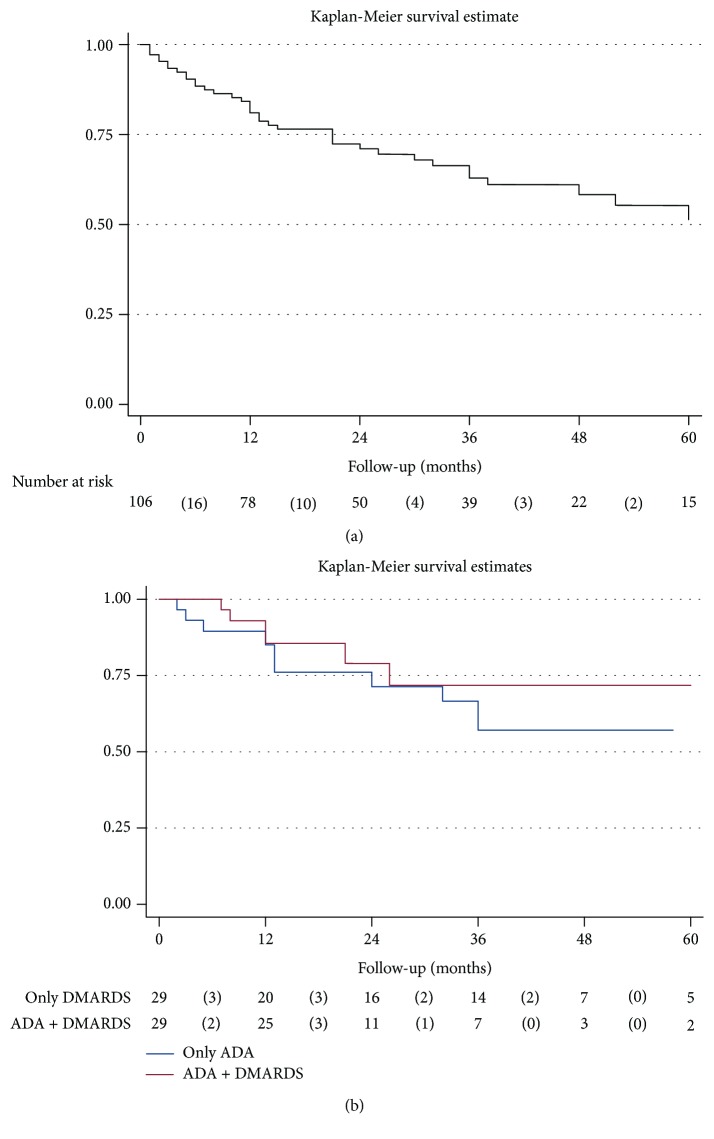
Drug retention rate on adalimumab treatment, overall (upper box) and stratified according to concomitant use of DMARDs vs. adalimumab in monotherapy (lower box). ADA: adalimumab; DMARDs: disease-modifying antirheumatic drugs.